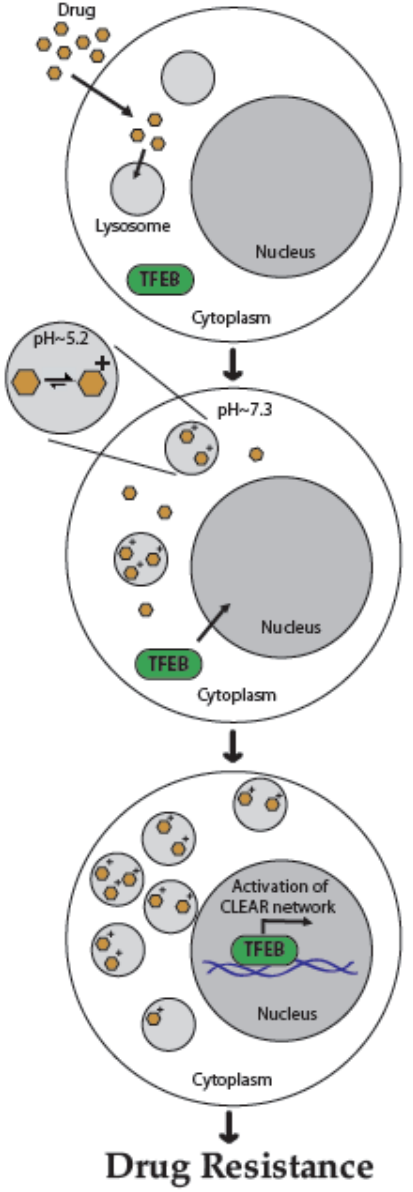
Figure 1. Schematic summary model for hydrophobic weak base drug-induced lysosome-mediated drug resistance. Hydrophobic weak base drugs enter the lysosomes by simple diffusion and undergo protonation in the acidic lysosomal lumen, thereby becoming irreversibly sequestered in lysosomes and acidic intracellular vesicles such as late endosomes. In turn, lysosomal drug sequestration triggers TFEB-mediated lysosomal biogenesis, resulting in a significant increase in the number of lysosomes per cell. Increased lysosome number per cell enhances the efficiency of lysosomal drug sequestration, with lysosomes acting as a sink pulling hydrophobic weak base drugs away from their cellular target sites, thereby resulting in MDR